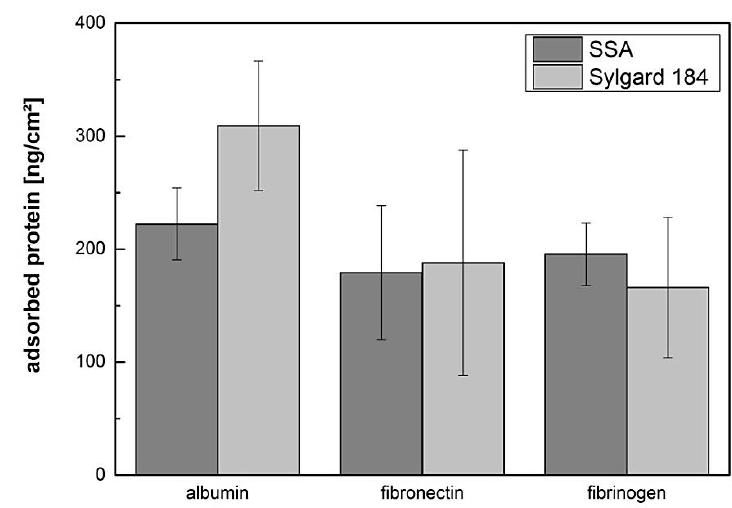
Figure 2. Protein adsorption on polymeric surfaces: Sylgard 184 and SSA single layers manufactured on PET foil were incubated in solutions of albumin (11.9 ± 3.7 µg/mL), fibronectin (10.3 ± 4.8 µg/mL), and fibrinogen (8.3 ± 3.6 µg/mL) for one hour at 37 °C. The amount of physically adsorbed protein was determined with microBCA spectrophotometric analysis and normalized to the surface area. Number of independently performed experiments n = 3. Statistical analysis revealed no difference while comparing SSA to Sylgard 184.